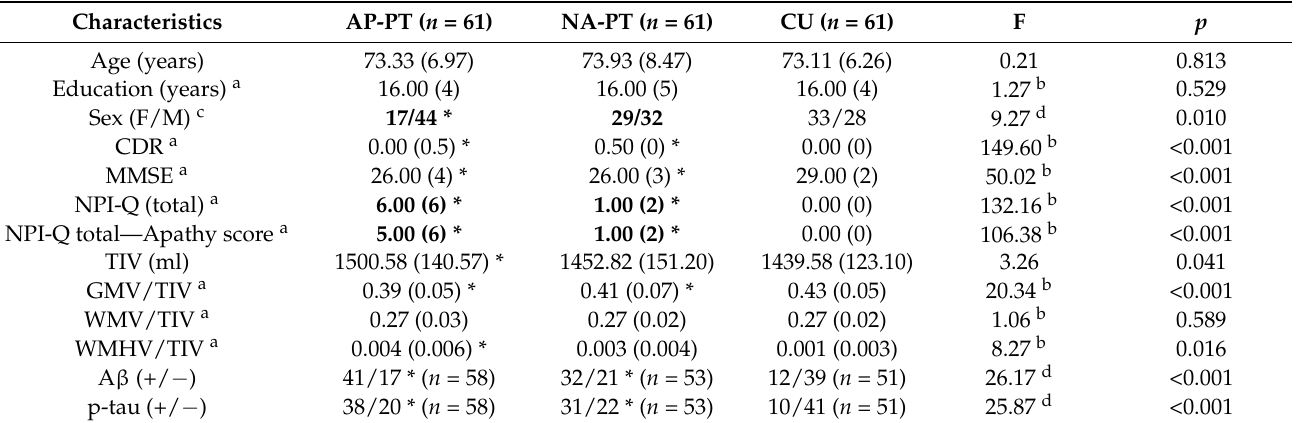
Table 1. Differences in demographic, clinical and neural characteristics across participant groups. Values are means and standard deviations unless otherwise specified.